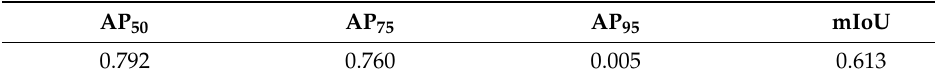
Table 6. Accuracy assessment of cultivation field-based mapping of sunscreen mature fruits (Unit: ha).